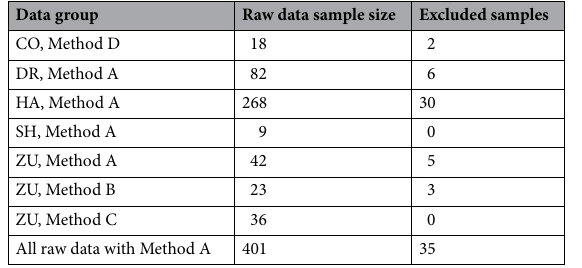
Table 1. Excluded data. Numbers are derived by applying the Tukey method with k =